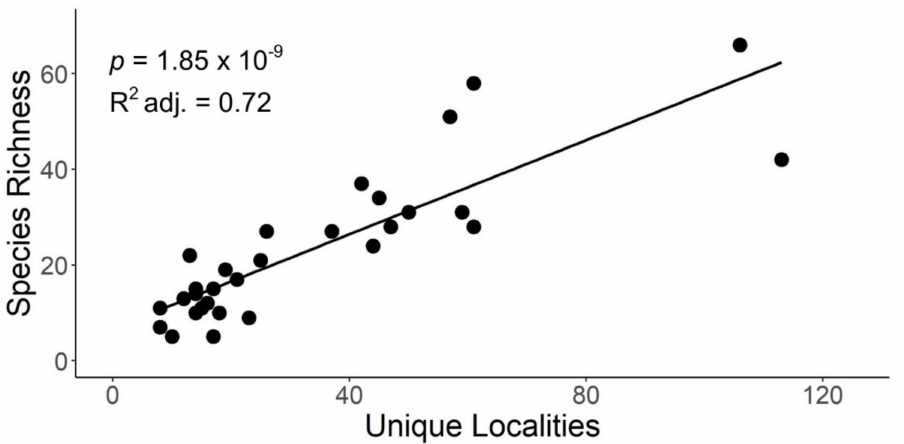
Figure 3. Scatterplot of stonefly species richness versus the unique localities within HUC8 watersheds of Indiana. Adjusted R 2 , probability, and line of best fit provided for simple linear regression